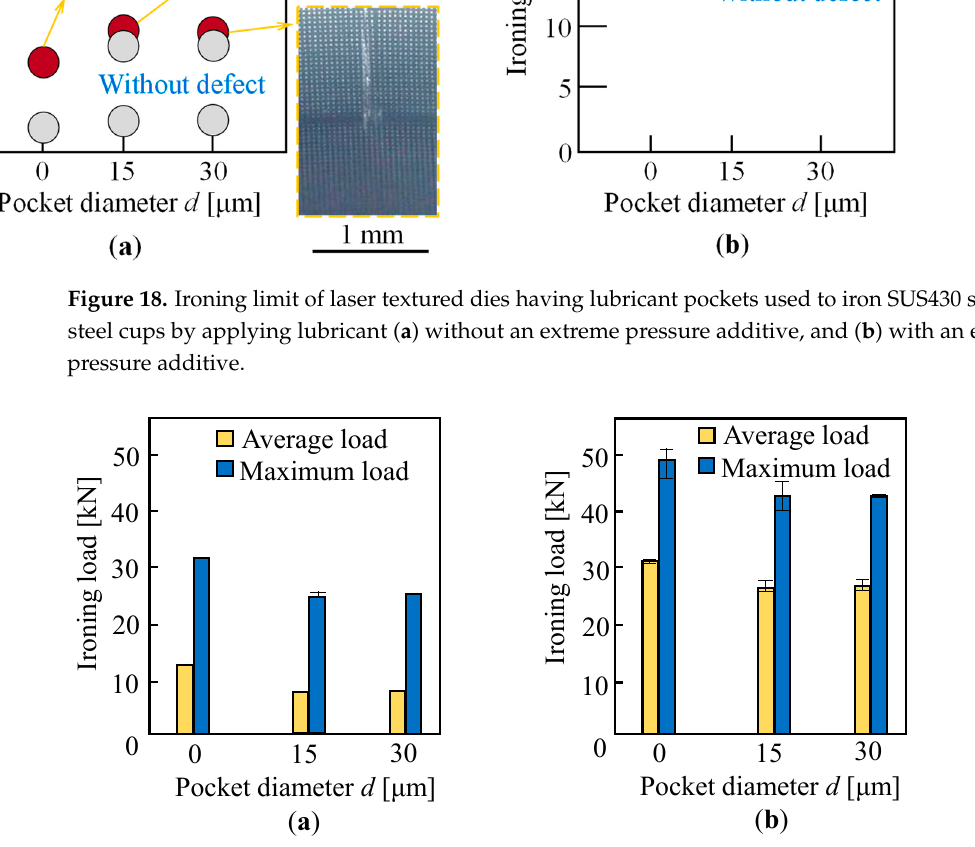
Figure 19. Ironing load of laser textured dies having lubricant pockets used to iron SUS430 stainless steel cups by applying lubricant ( a ) without an extreme pressure additive at r = 3%, and ( b ) with an extreme pressure additive at r = 8%.